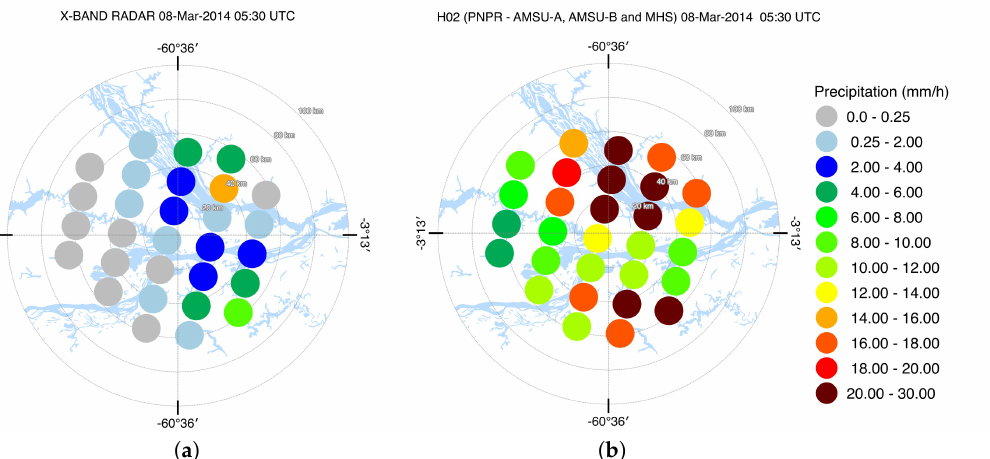
Figure 13. ( a ) Rain rate from radar upscaled to the satellite grid and ( b ) H02 rain rate map in Manaus on 8 March 2014 at 05:30